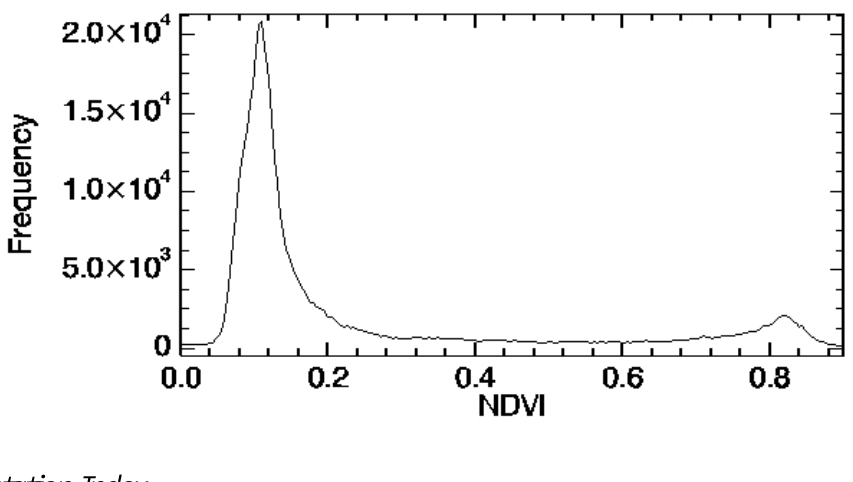
Figure 6. NDVI histogram extracted from the CHRIS